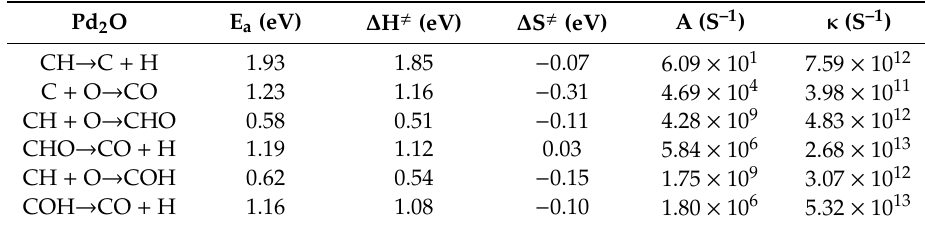
Table 7. The activation energy (E a ), di ff erence enthalpy between the transition state and the initial state ( ∆ H (cid:44) ), di ff erence entropies between the transition state and the initial state ( ∆ S (cid:44) ), pre-exponential factor (A), rate constant ( κ ) for methane activation on Pd 2 O. Pd 2 O E a (eV) ∆ H (cid:44)